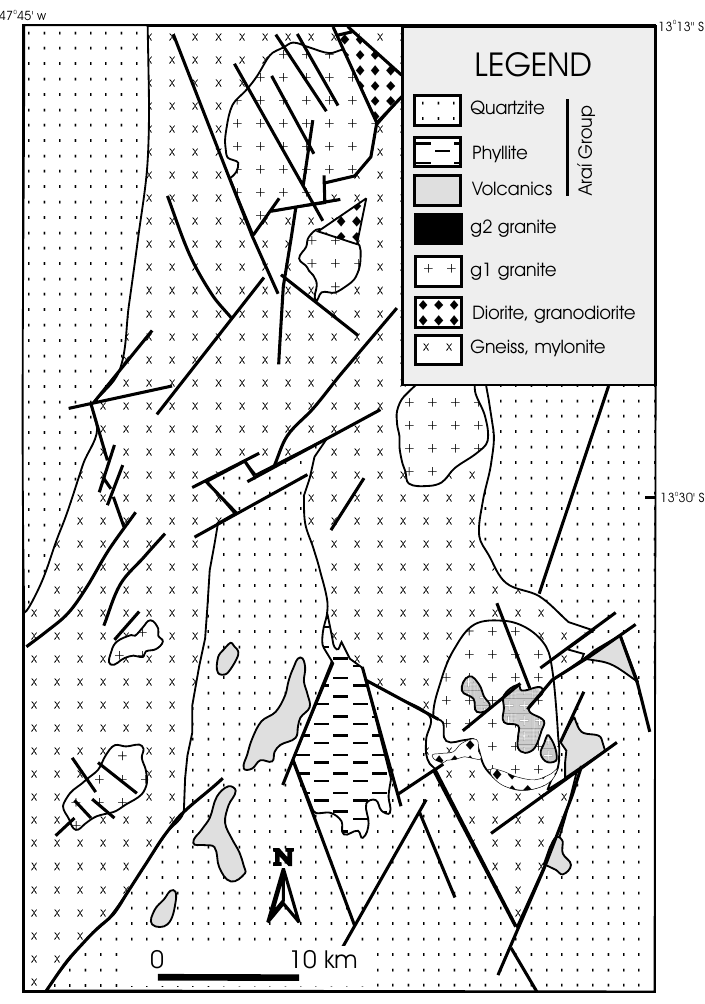
Fig. 3 – Geologic map of the Rio Paranã subprovince. g1 and g2 granites within the Serra da Pedra Branca granite are